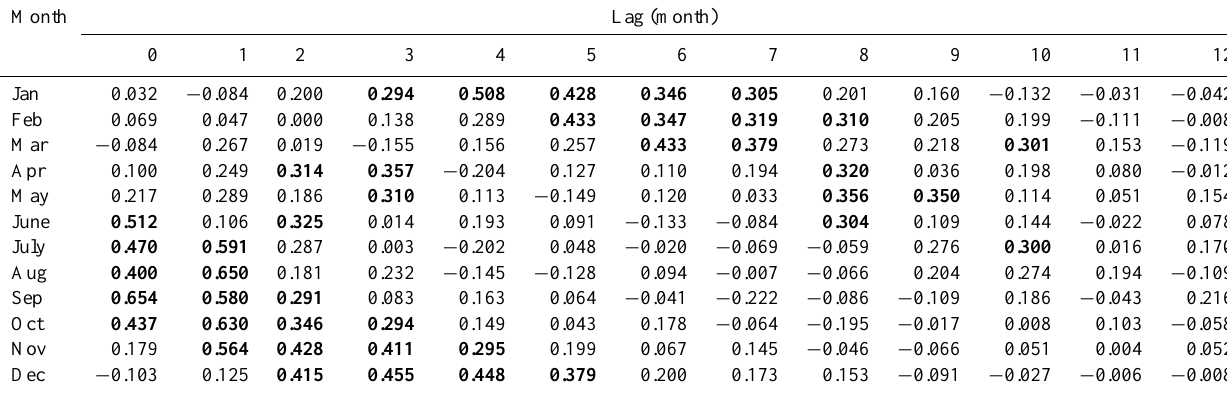
Table 1. The correlations between monthly runoff and monthly precipitation with different lag month.